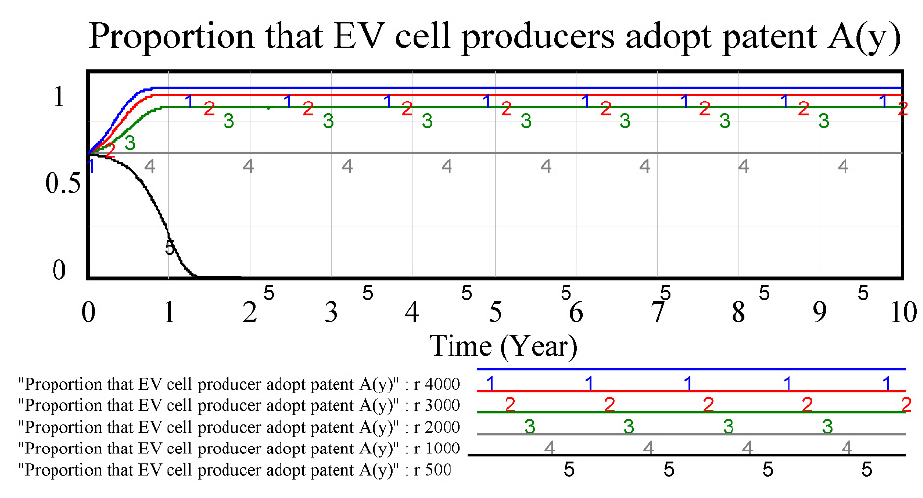
Figure 3. Sensitivity test of factor r that impacts EV cell producer.